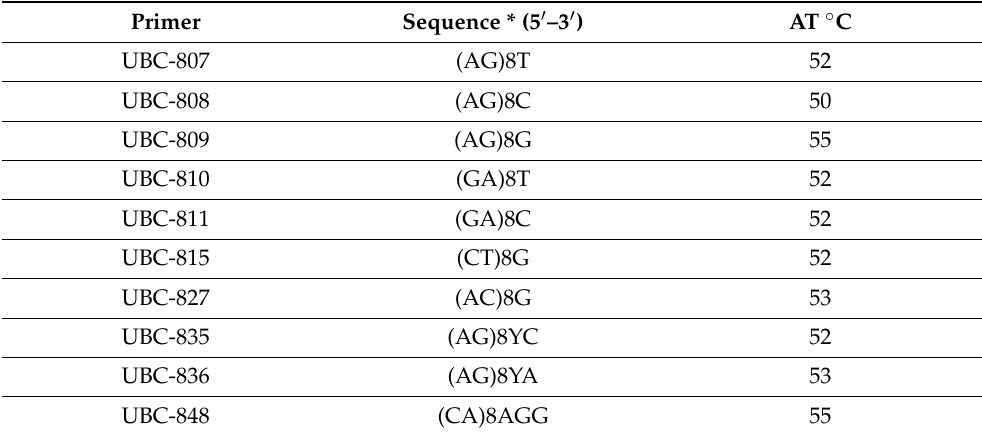
Table 1. Inter-simple sequence-repeat (ISSR) primers used to identify BC 3 F 2 genotypes with higher recurrent genome recovery. AT ◦ C, annealing temperature.